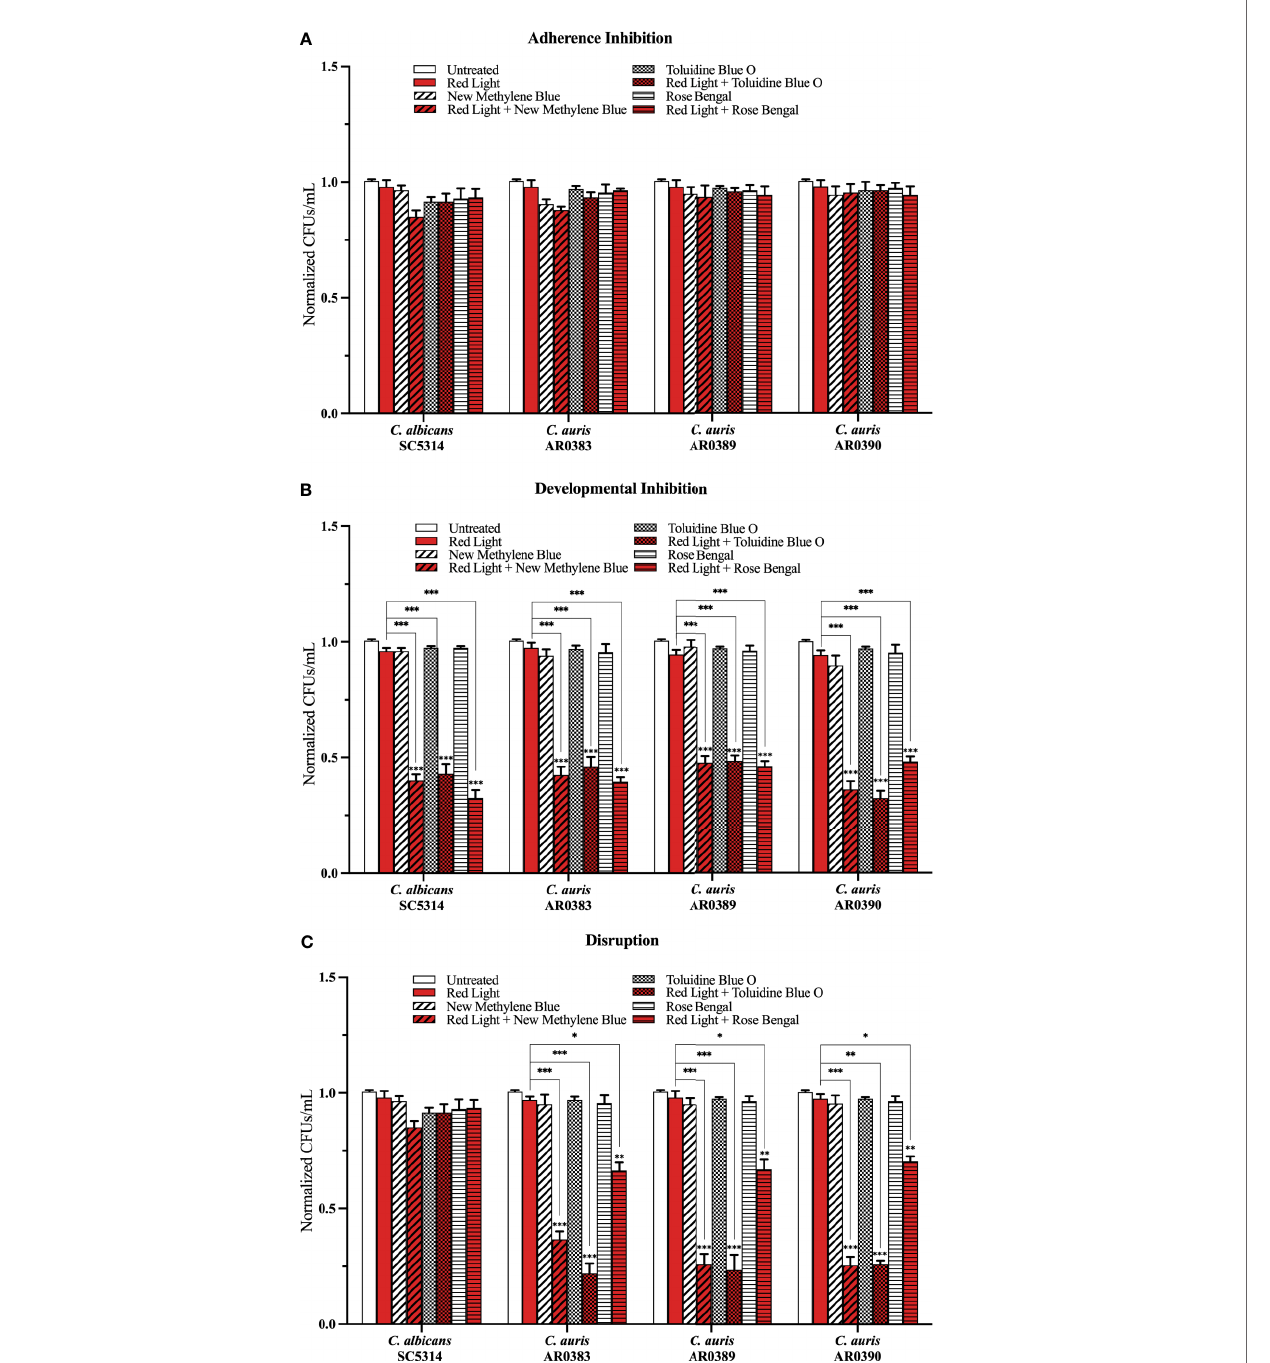
FIGURE 3 | Red visible light in combination with photosensitizing compounds is effective against C . auris bio fi lms. C albicans (SC5314) and C . auris (AR0383, AR0389, and AR0390) bio fi lms were exposed to red visible light with and without the photosensitizing compound indicated in the (A) adherence inhibition, (B) developmental inhibition, and (C) disruption bio fi lm assays. Untreated control (Untreated), red light alone (Red Light), photosensitizing compound alone (New Methylene Blue, Toluidine Blue O, and Rose Bengal), and red light in combination with the photosensitizing compound (Red Light + New Methylene Blue, Red Light + Toluidine Blue O, and Red Light + Rose Bengal) are shown. CFUs/mL were measured to determine viable cell counts from the bio fi lms at the end of each bio fi lm assay. Standard deviations are shown for each sample (n = 3). The average CFUs/mL of the untreated control samples for each assay were normalized to 1. Signi fi cance comparisons are relative to the untreated control unless otherwise noted with signi fi cance bars and were determined using student ’ s unpaired two-tailed t-tests assuming unequal variance for p ≤ 0.05 (*), p ≤ 0.01 (**), and p ≤ 0.001